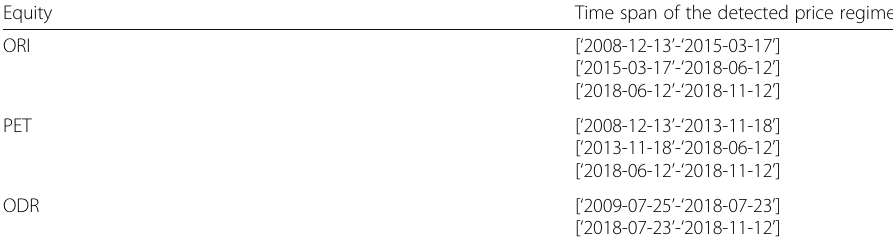
Table 8 The time span of the detected price regimes, for the equity sectors